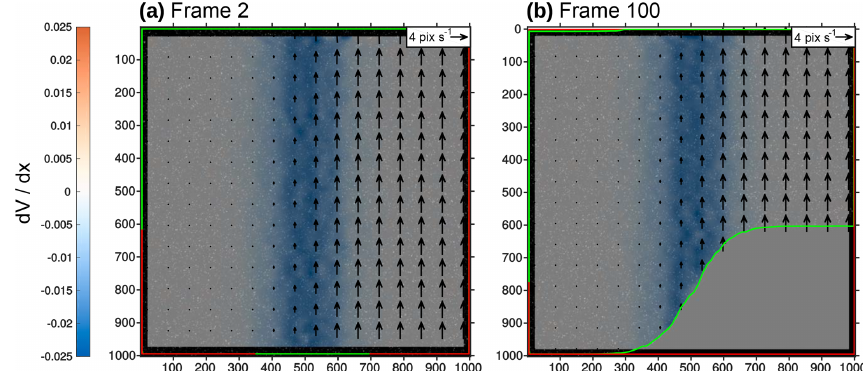
Figure 3. Synthetic static shear zone test at frame 2 (a) and 100 (b) . Width of the shear zone: W sz = 512 pixels; y component of the velocity vector: v = 4 pixels. Red is the region of interest (ROI); green is the deformed